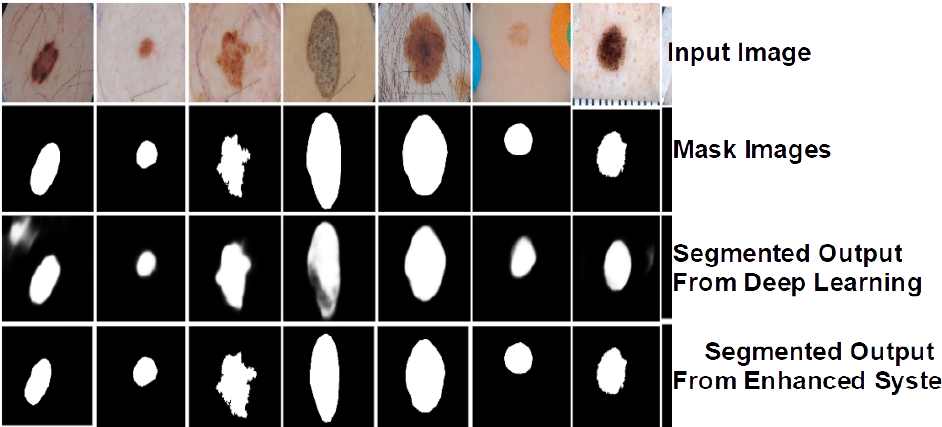
Figure 5. The figure shows the segmentation outcomes of the system on the ISBI 2017 dataset: The first row represents the input images; the second rows represents the ground truth labels; the third row represent segmented results on the deep learning model; and the last row shows the segmented results of the enhanced